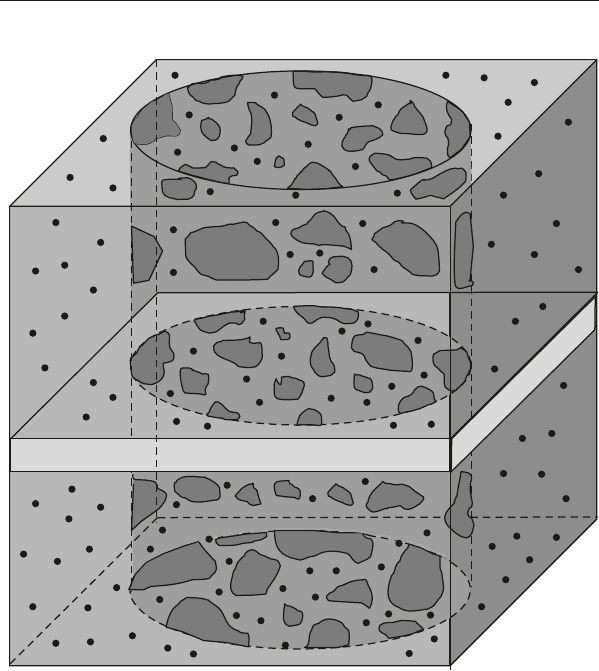
Figure 1: Waste concrete specimen with a core